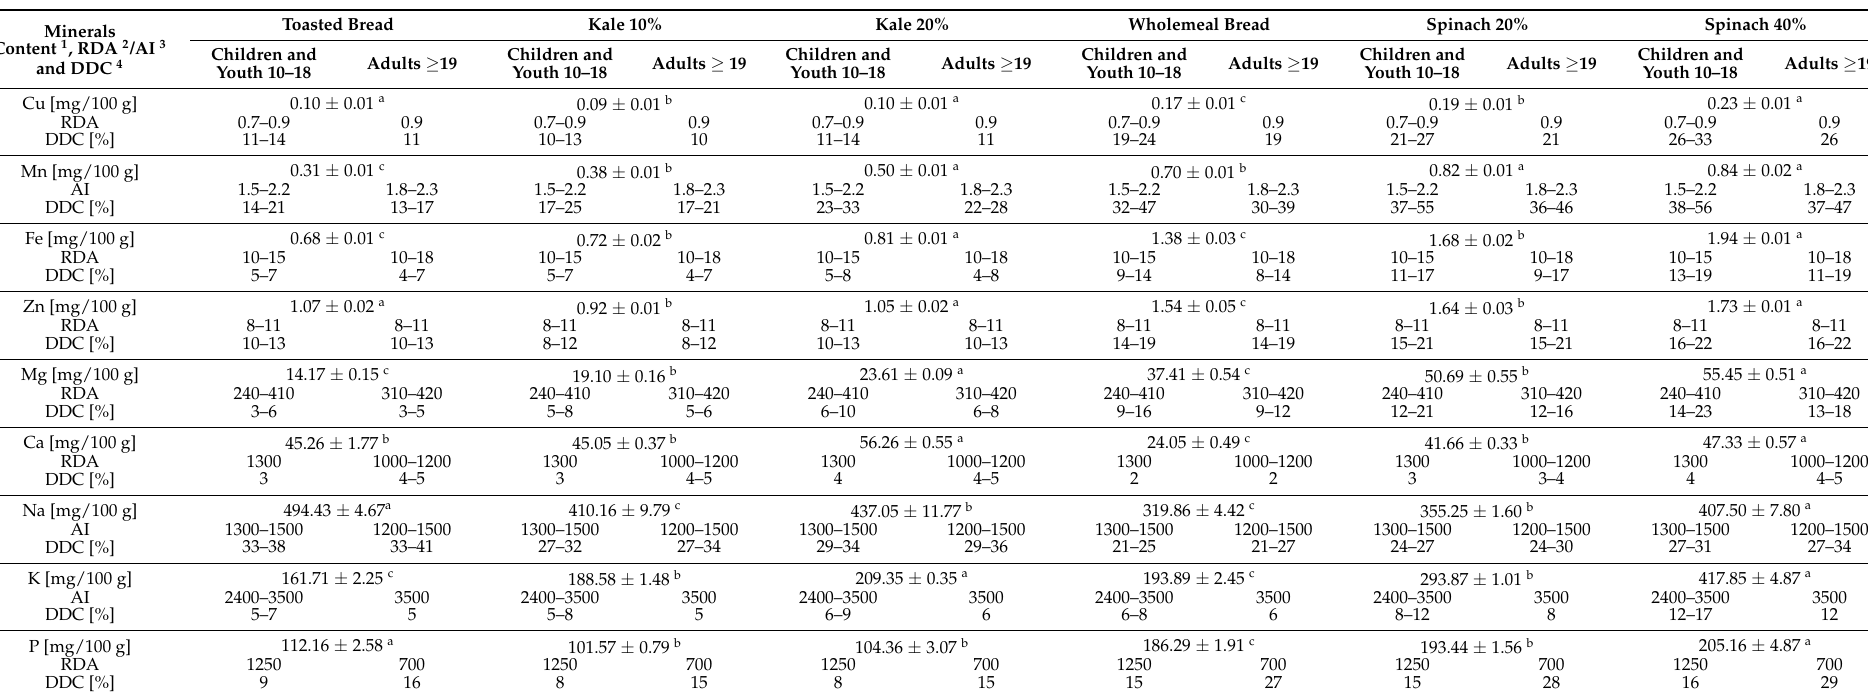
Table 3. Mineral content in the tested breads and the coverage of the daily demand for selected minerals after consuming a 100 g portion of